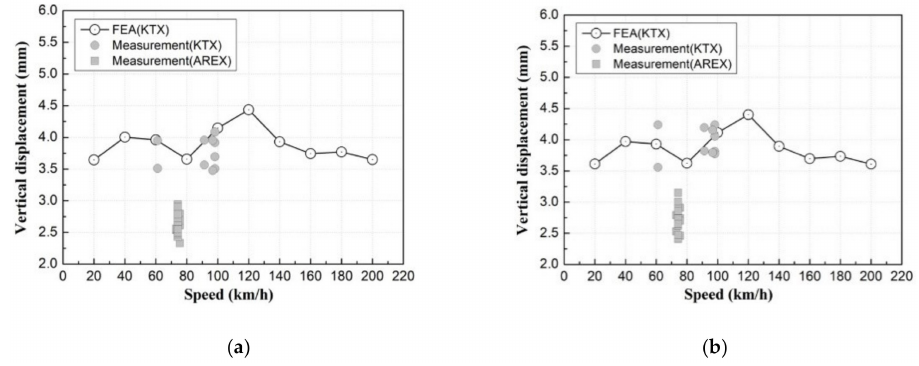
Figure 6. Analytical results of vertical displacements of rail and track girder. ( a ) Rail vertical displacement; ( b ) Track girder vertical